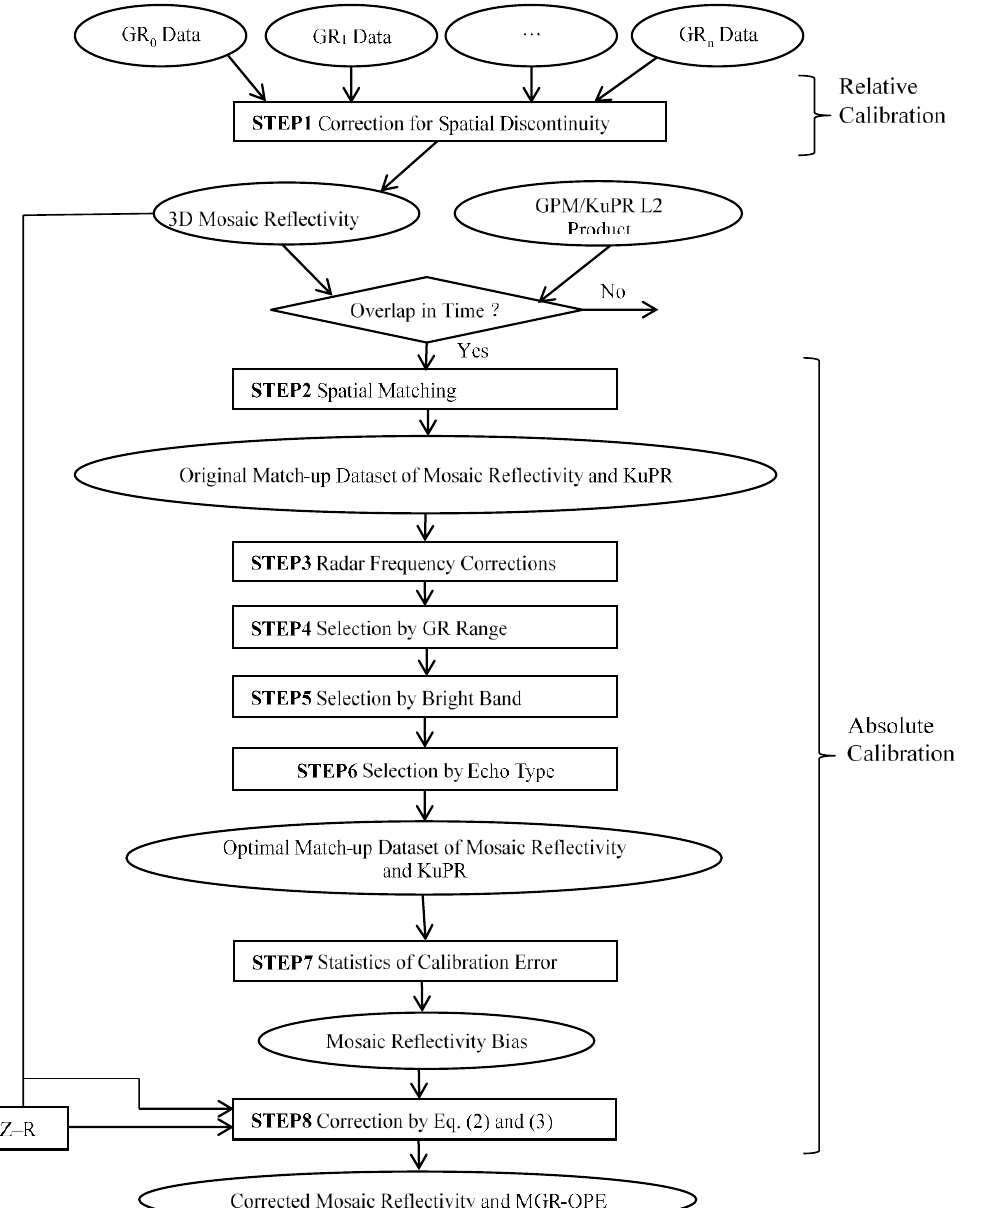
Figure 4. Flow chart of the proposed M-ABCD method. Ellipses indicate radar data or match-up datasets, and rectangles indicate processing steps. STEP1 is correction for spatial discontinuity, and STEP2–STEP8 are correction for calibration errors.